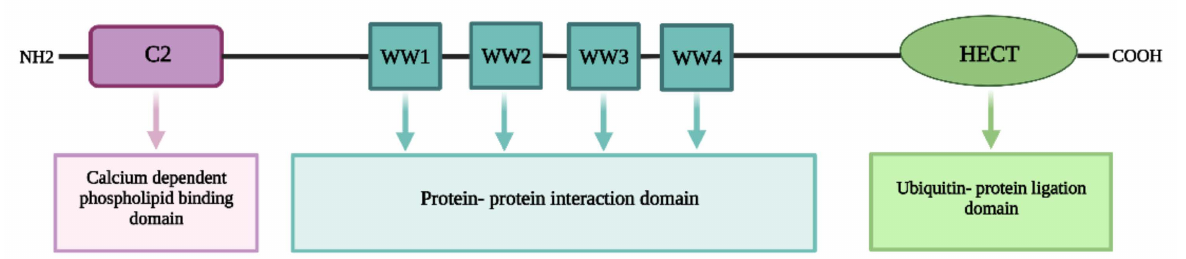
Figure 2. General structure of NEDD4/NEDD4-like E3 ligase . Contains an N-terminal C2 domain for membrane binding, a central two to four double tryptophan residue (WW) domain for protein– protein interaction and a C-terminal HECT domain for ubiquitin–protein ligation, Created using